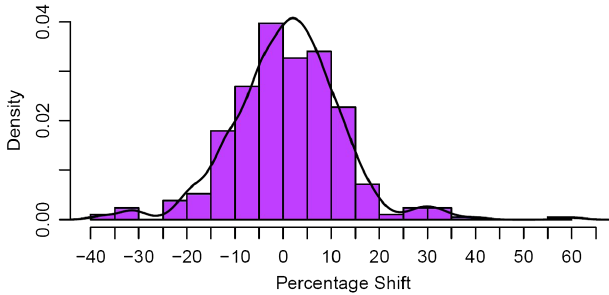
FIG. 5. Distributions of score shifts between pre- and post- responses of proposed 11-item instrument — bolded line repre- sents the histogram density